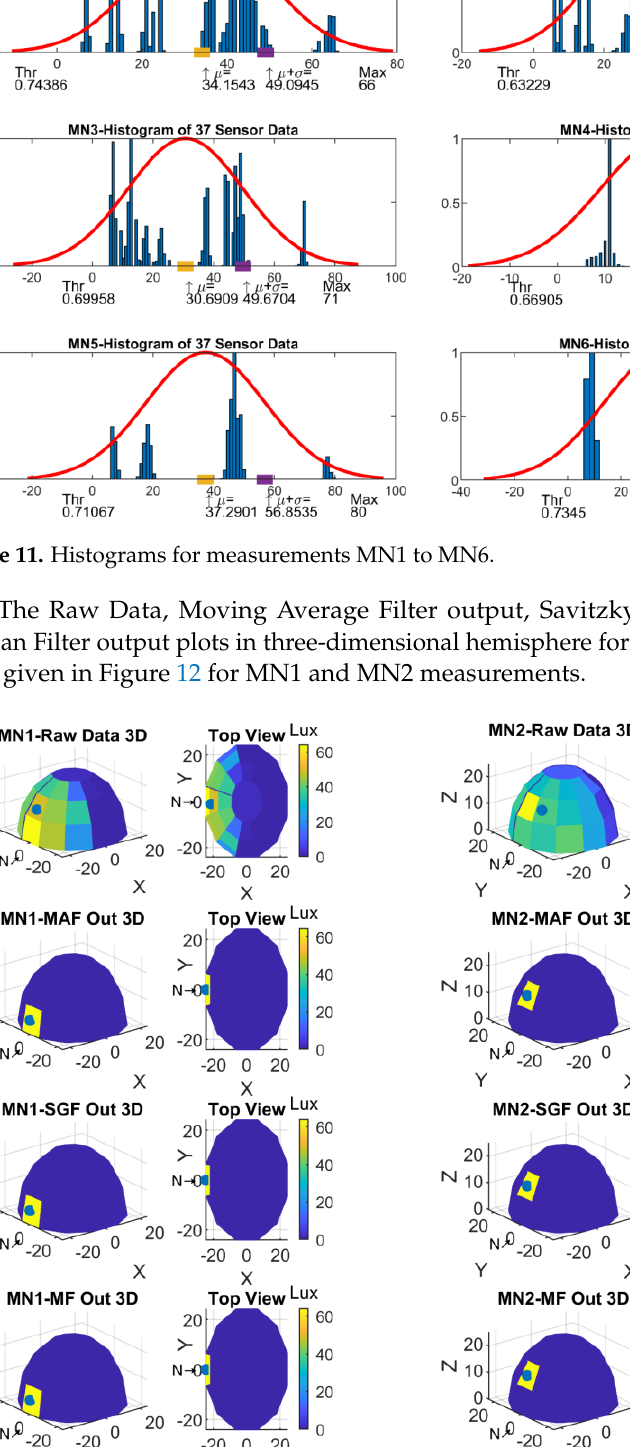
Figure 13. Spherical and top view of MN3 and MN4 experiment result.